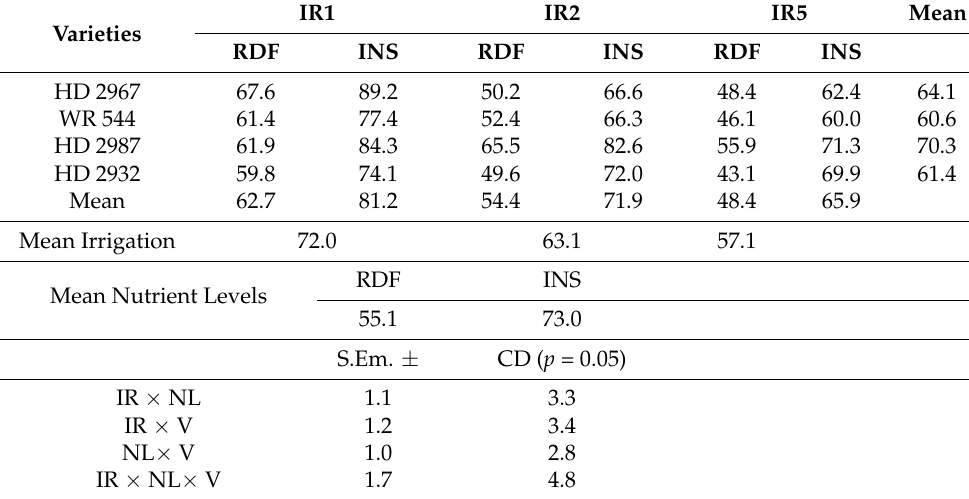
Table 9. Interaction effect of nutrient management levels, irrigation schedules, and varieties on microbial biomass carbon ( µ g/g soil).